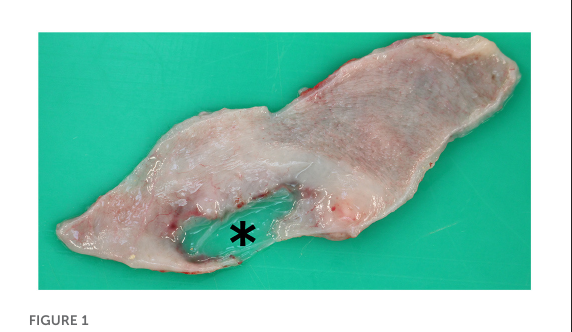
FIGURE1 Macroscopic image of the urinary bladder. (Subscript) Local lesion of the bladder wall measuring 1cm in diameter and only covered by a translucent mucosal membrane (asterisk).